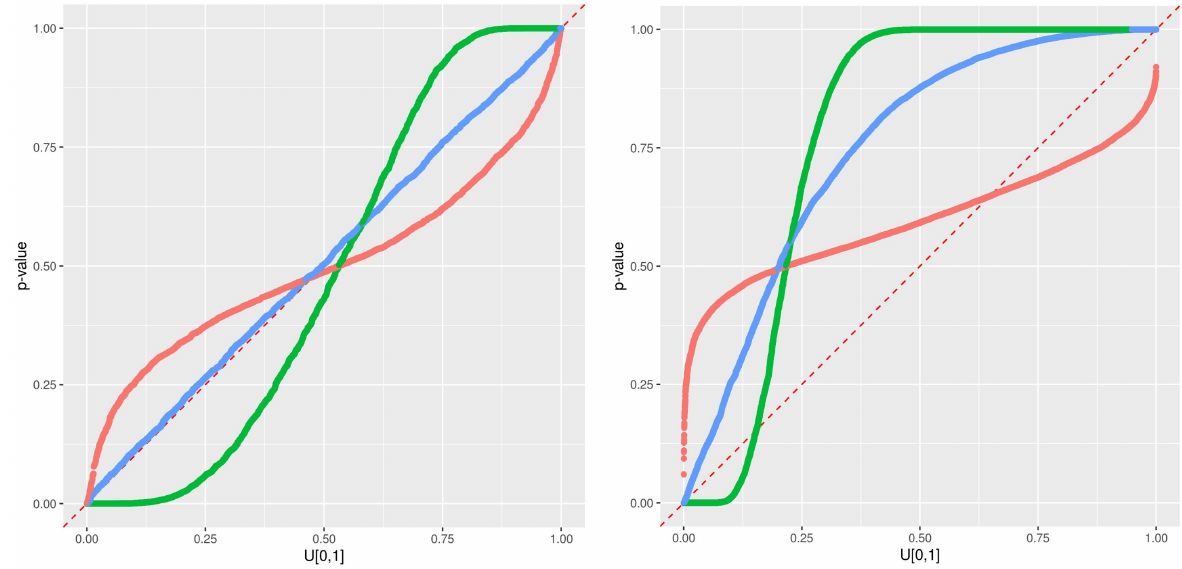
Figure 10. Results at Station 504. Predictive qq-plot for the training/testing period 2017–2018 ( left ). Predictive qq-plot for the validation period 2015–2016 ( right ). The different methods are colored in red for Eaamm 2010, green for Wager 2014 and blue for Lu 2019.